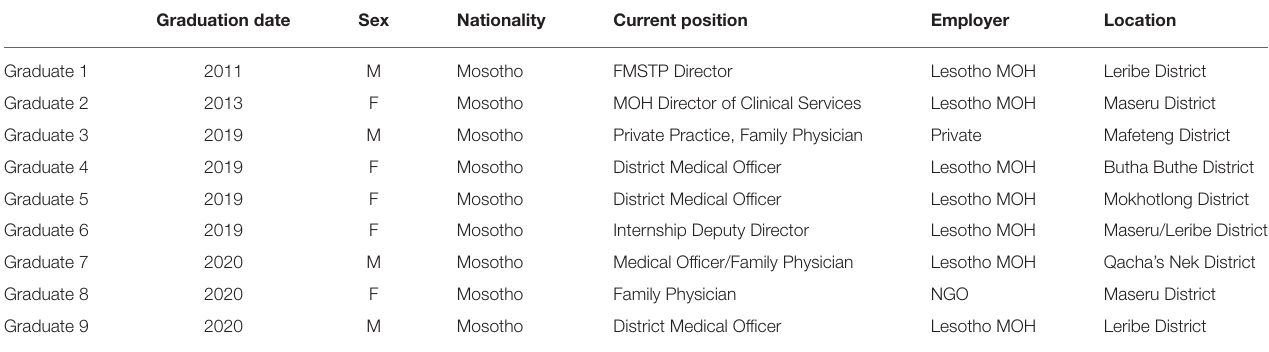
TABLE 1 | Profile of FMSTP